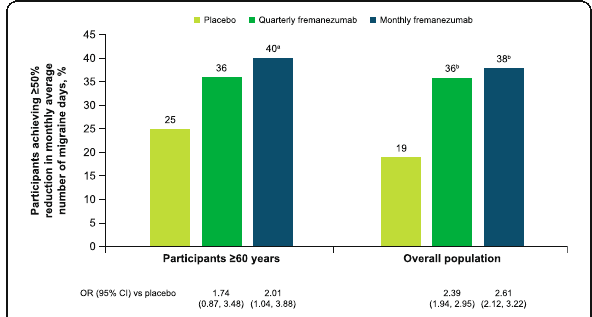
Fig. 4 Participants achieving ≥ 50% response in participants aged ≥ 60 years and overall population. OR, odds ratio; CI, confidence interval. A ≥ 50% response was defined as a ≥ 50% reduction from baseline in the monthly average number of migraine days during 12 weeks of double-blind treatment. a P < 0.05 vs placebo. b P < 0.0001 vs